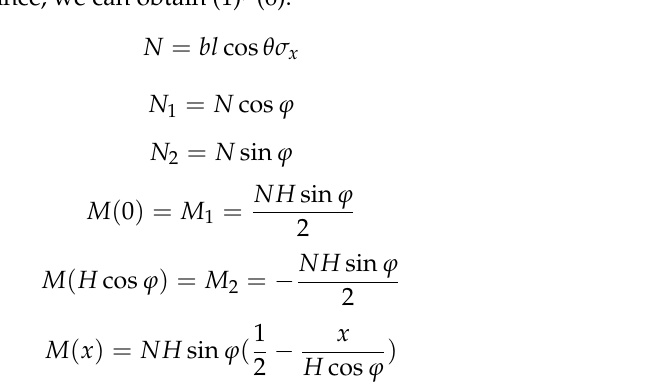
Using Castiglino’s Theorem, the deflection is equal to the partial derivative of strain energy, and we can obtain the deflection δ x .